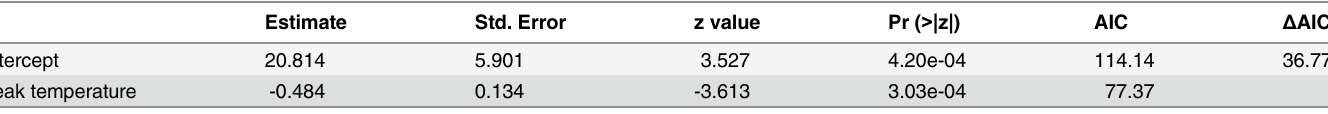
Table 5. Output summary of the logistic regression model of survival of E . atala pupae as a function of in situ peak temperature following pre- scribed burning July 5 th -6th, 2012, at the Ordway Swisher Biological Station, Melrose, Florida. Estimate